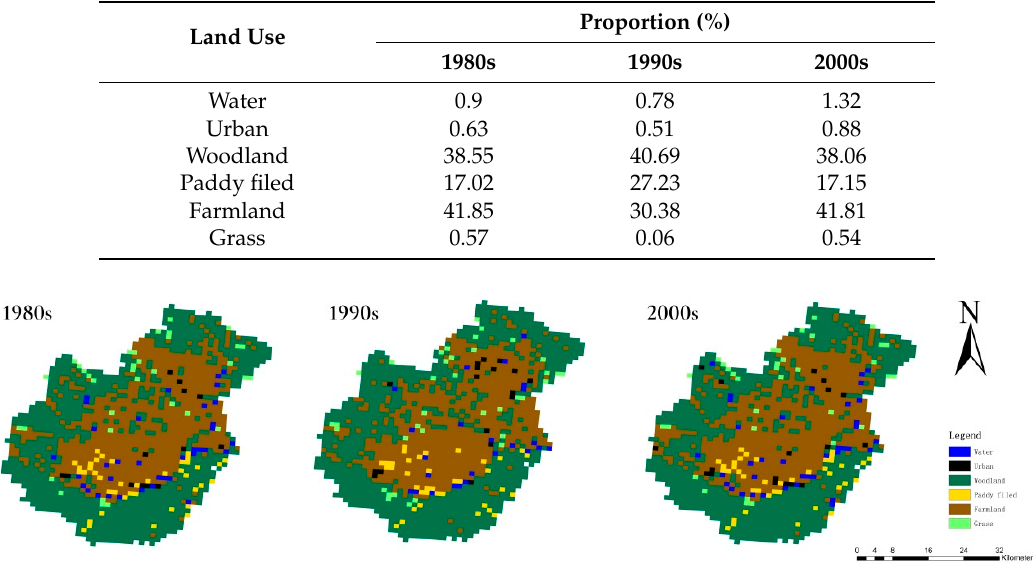
Figure 2. The land use type of the three periods.